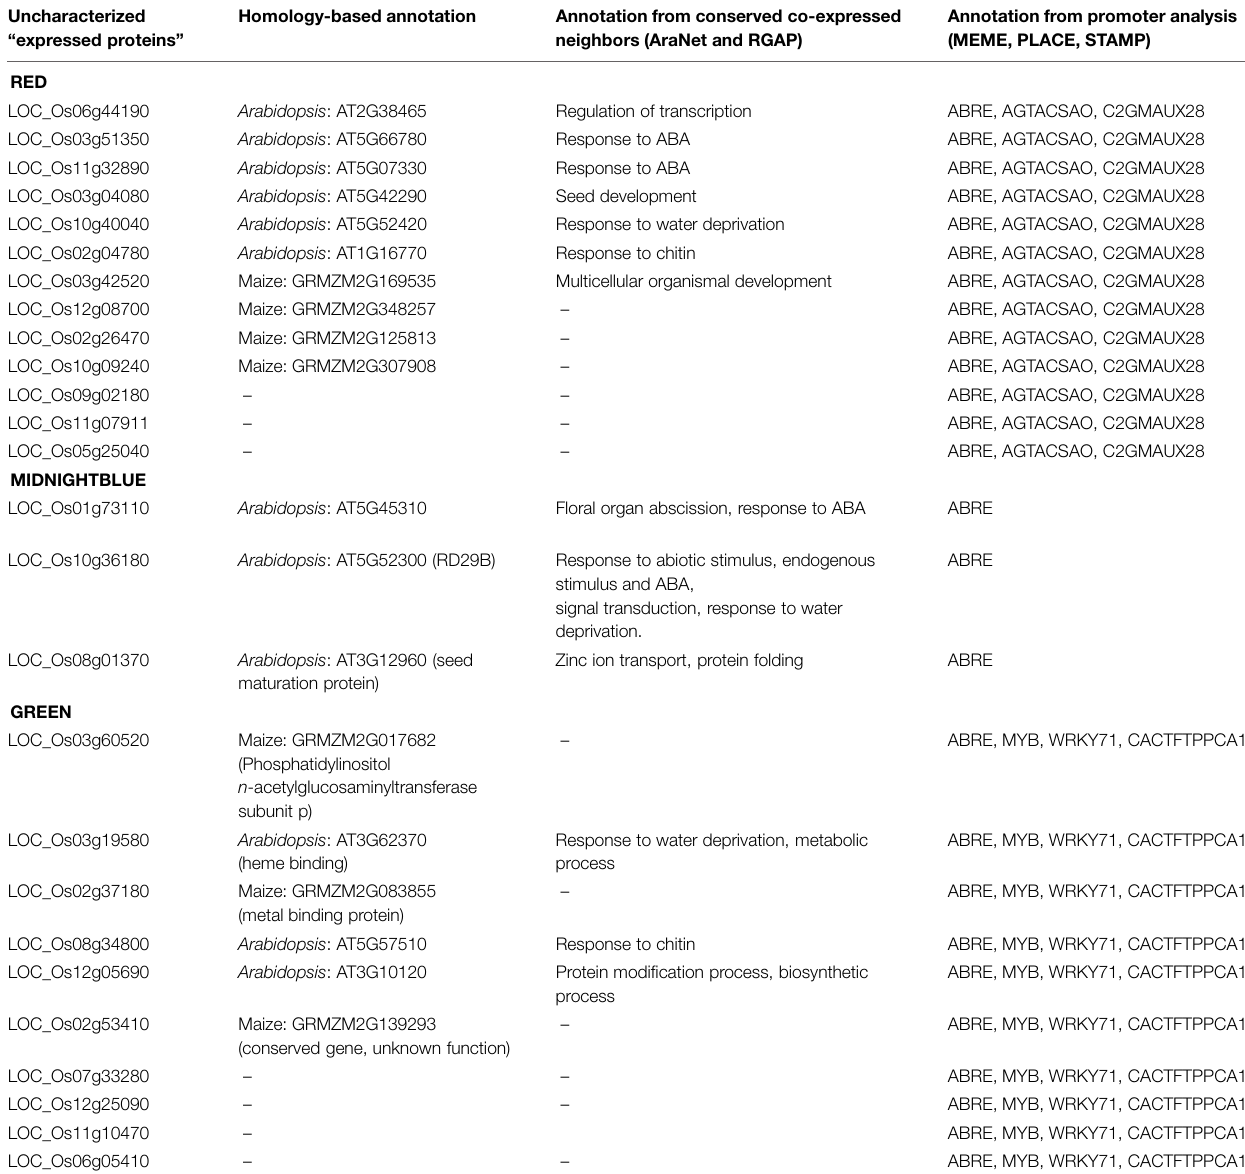
TABLE 1 | Functional annotation of uncharacterized genes in red, midnightblue, and green modules. Uncharacterized “expressed